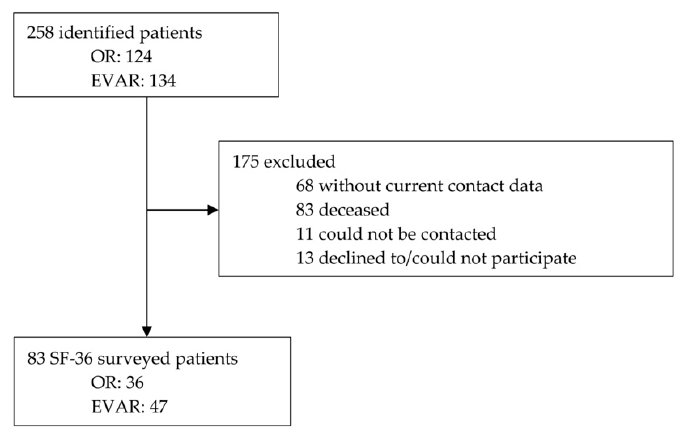
Figure 1. Trial profile. From 2008 to 2016, 258 patients were treated with open or endovascular repair at the University Medical Center. After exclusion of 175 cases, 83 patients were included in the study. Health-related quality of life was assessed by means of the SF-36 questionnaire. OR: open repair; EVAR: endovascular aortic repair.